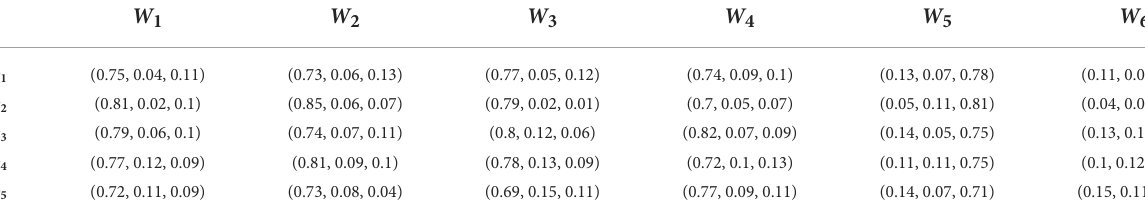
TABLE 1 Decision matrix given by the first expert E 1 .